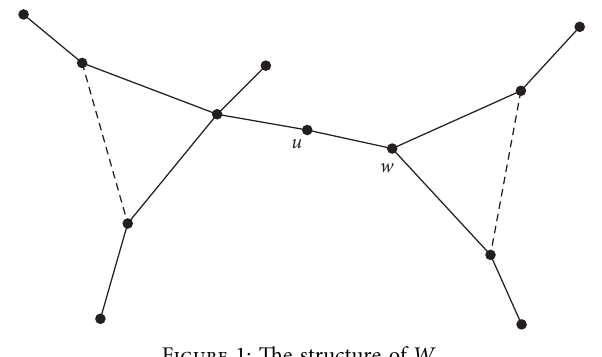
Figure 1: The structure of W